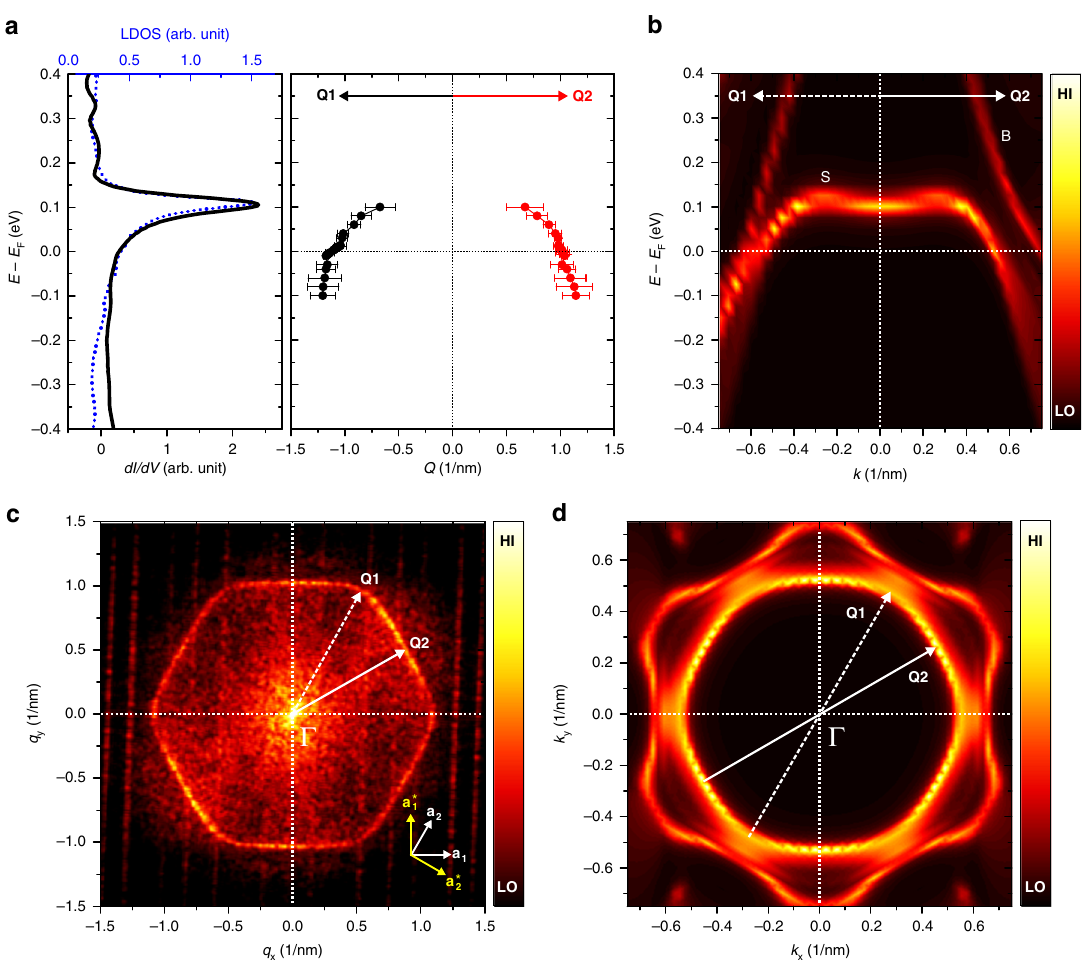
Fig. 2 Quasi-two-dimensional surface electronic structure of La(0001). a (left) Differential tunneling conductance spectrum in a wide energy range on a clean La(0001) surface (black solid line) and calculated LDOS in the vacuum 3 Å above the surface (blue dotted line). The pronounced peak around E = 0.1meV can be attributed to a d-type surface state. (right) Extracted dispersion relation from the FT of the bias-dependent dI / dV maps (see [Supplementary Note 4 and Supplementary Fig. 4]) along the Q1 and Q2 directions. The error bars correspond to the full width at half maximum of the Gaussian fi tting for the peak in the line section of FT maps. b Calculated Bloch spectral function (BSF) for the surface atomic layer of La(0001) along the Q1 and Q2 directions. c The 2D FT of the dI/dV map at V S =+ 3.0mV showing a hexagonal scattering pattern. d BSF at the Fermi energy for the surface atomic layer, highlighting the FS formed by the surface bands. The white arrows present the corresponding quasiparticle scattering processes in ( c